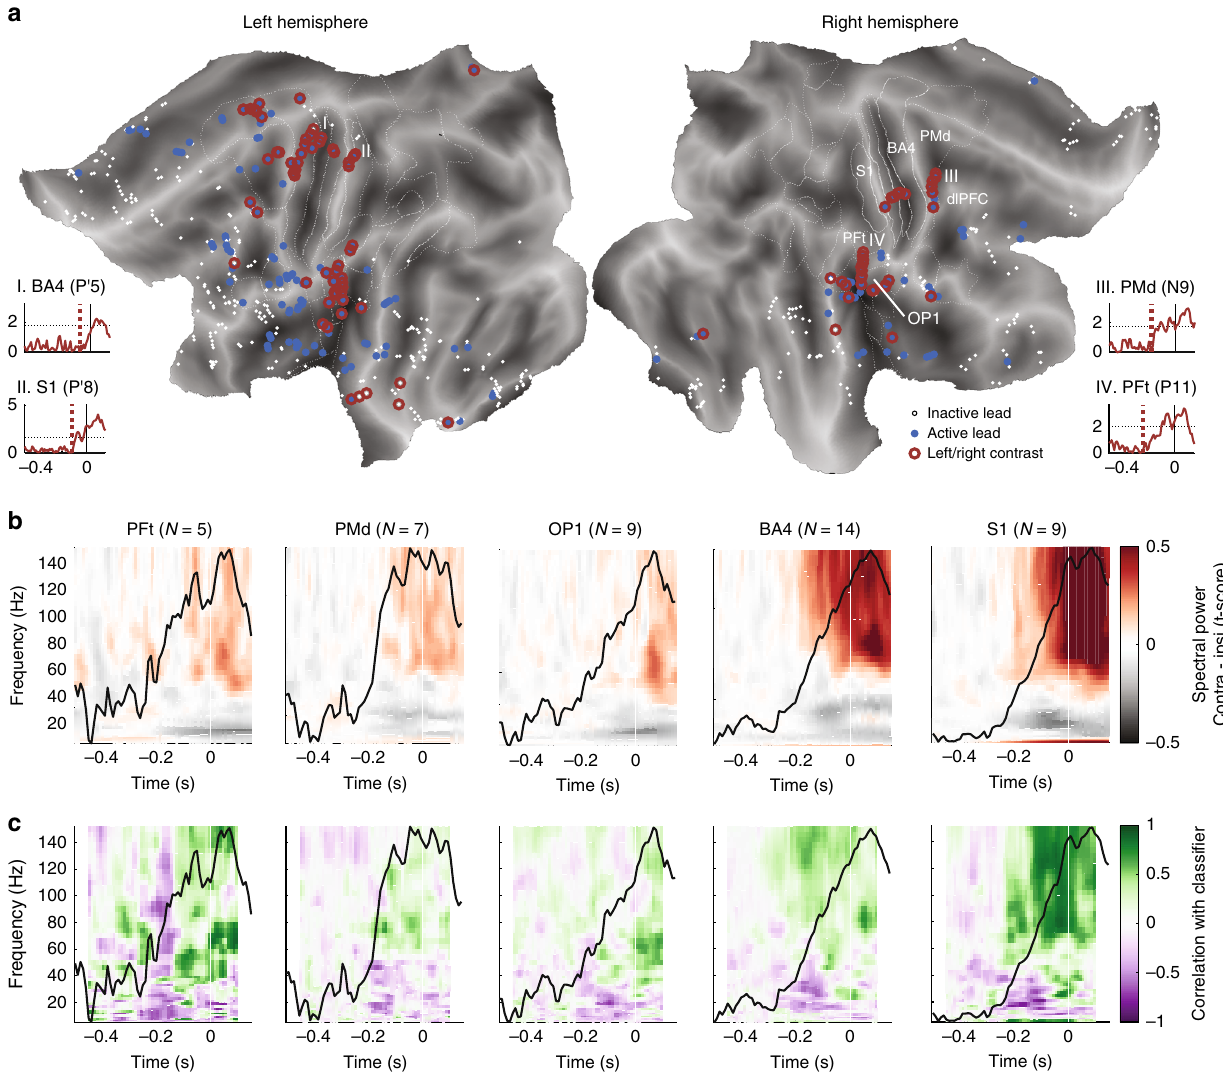
Fig. 2 LDA classi fi er identi fi ed leads that carry decision information. a Flatmaps showing, for all recorded leads across six patients whether a signi fi cant response-locked change from baseline was detected (blue dots) and/or the left/right decision was successfully decoded (red circles), or whether their activity did not differ from baseline in the interval starting 0.5 s before and ending 0.15 s after the response (white dots). Brain areas of interest are indicated by white outlines. The insets show the t -scored classi fi cation performance of four example left/right decoding leads (indicated by I – IV on the fl atmaps). Dotted lines indicate the onset of temporal cluster of the signi fi cant classi fi cation. For full labeling of areas see Supplementary Fig. 1; b average spectral power per area (number of leads given in brackets), including only those leads that showed signi fi cant decoding of the left/right decision. To combine data recorded in both hemispheres, data were contrasted as contralateral (i.e., left button presses when recording in the right hemisphere) versus ipsilateral decisions (i.e., right button presses when recording in the right hemisphere); c average correlation per area between spectral power and classi fi cation performance across all left/right decoding leads. Correlations were computed using a 100 ms wide sliding window. Green indicates that power increase related to high classi fi cation performance and purple indicates that power decrease co-occurred with high classi fi cation performance. In b and c , black lines give the average response-locked classi fi er performance across leads in the area, normalized to the peak performance ( y -scale between 0 and 1). Non-scaled performances per lead are given in Supplementary Fig. 4, stimulus-locked and response-locked classi fi er performance are compared in Supplementary Fig. 5, and spectral power and power-classi fi er correlations for all other areas of interest can be found in Supplementary Figs. 6 – classi fi er, we used a left/right contrast to identify regions that represent the decision. However, to pool these results across subjects, we converted this to a contra-ipsilateral hemisphere contrast, as two subjects were implanted in the right hemisphere and four subjects in the left hemisphere. Spectral power for contra- and ipsilateral trials are given separately in Supplemen- tary Fig. 7.